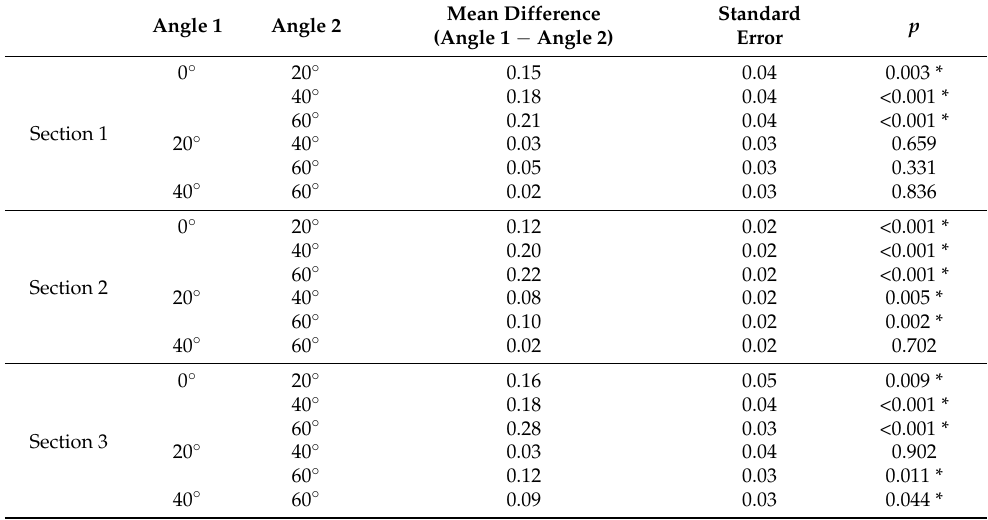
Table 2. Comparison of the ratios of length changes by curl-up angle in each